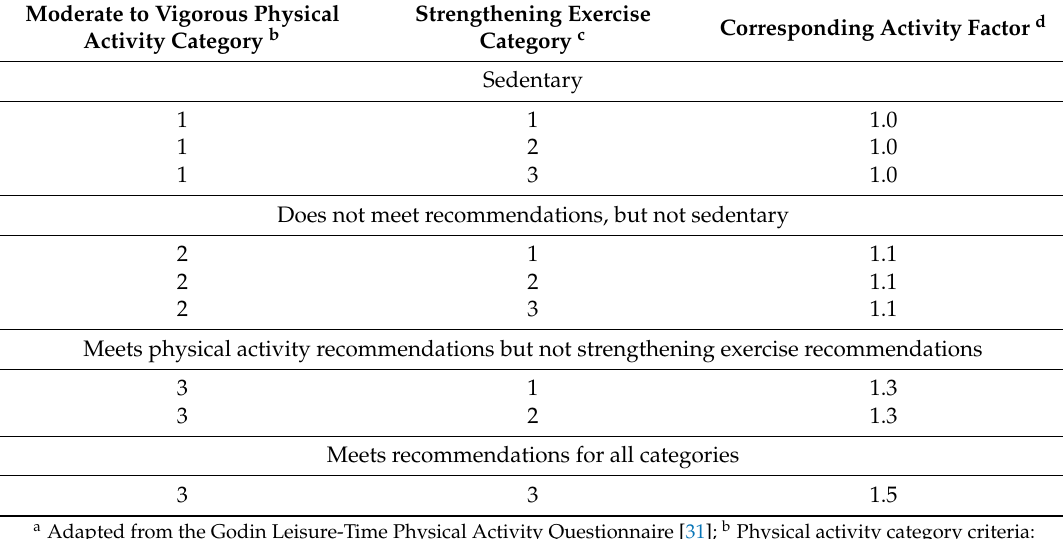
Table 2. Estimating Activity Factors using the Godin Physical Activity Questionnaire a